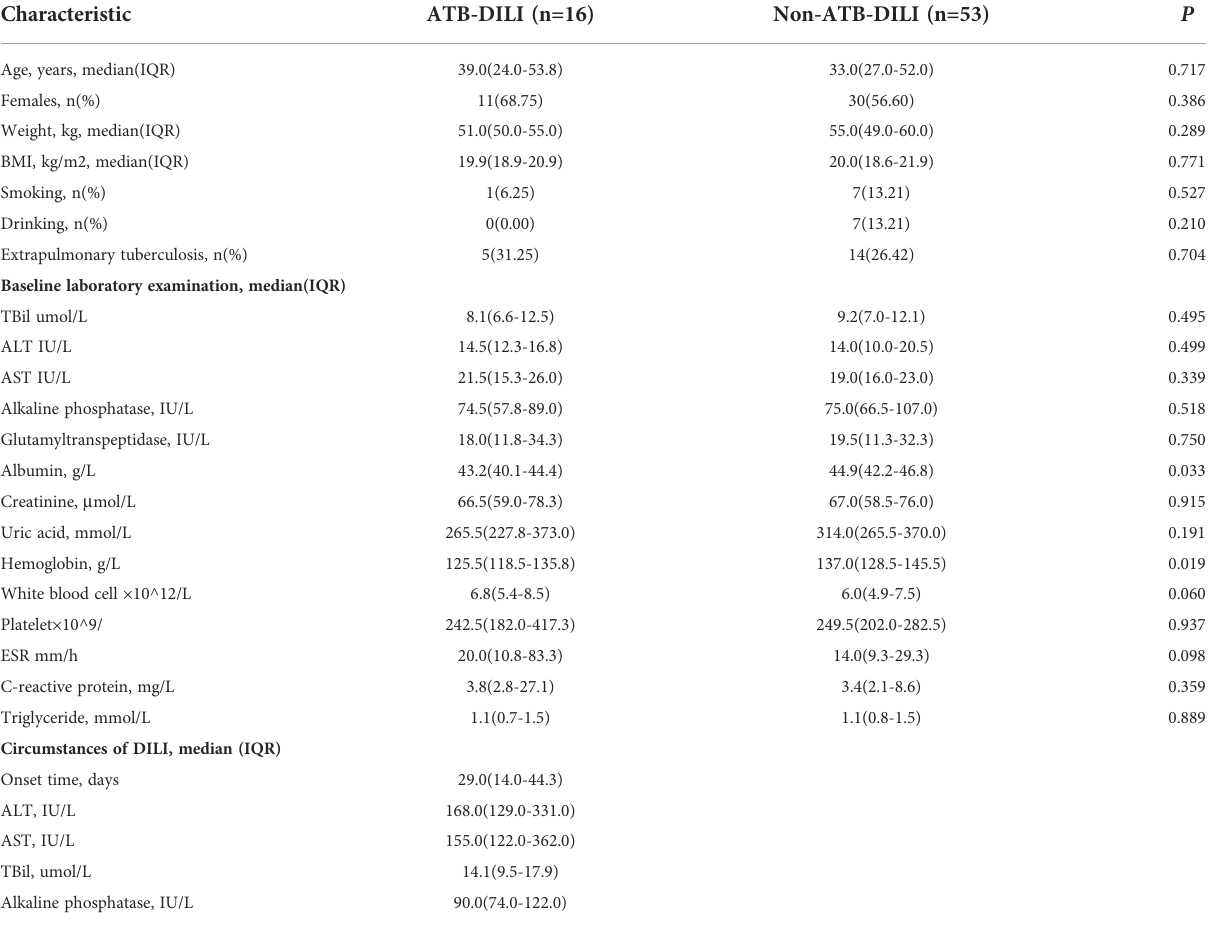
TABLE 1 Clinical characteristics of 69 tuberculosis